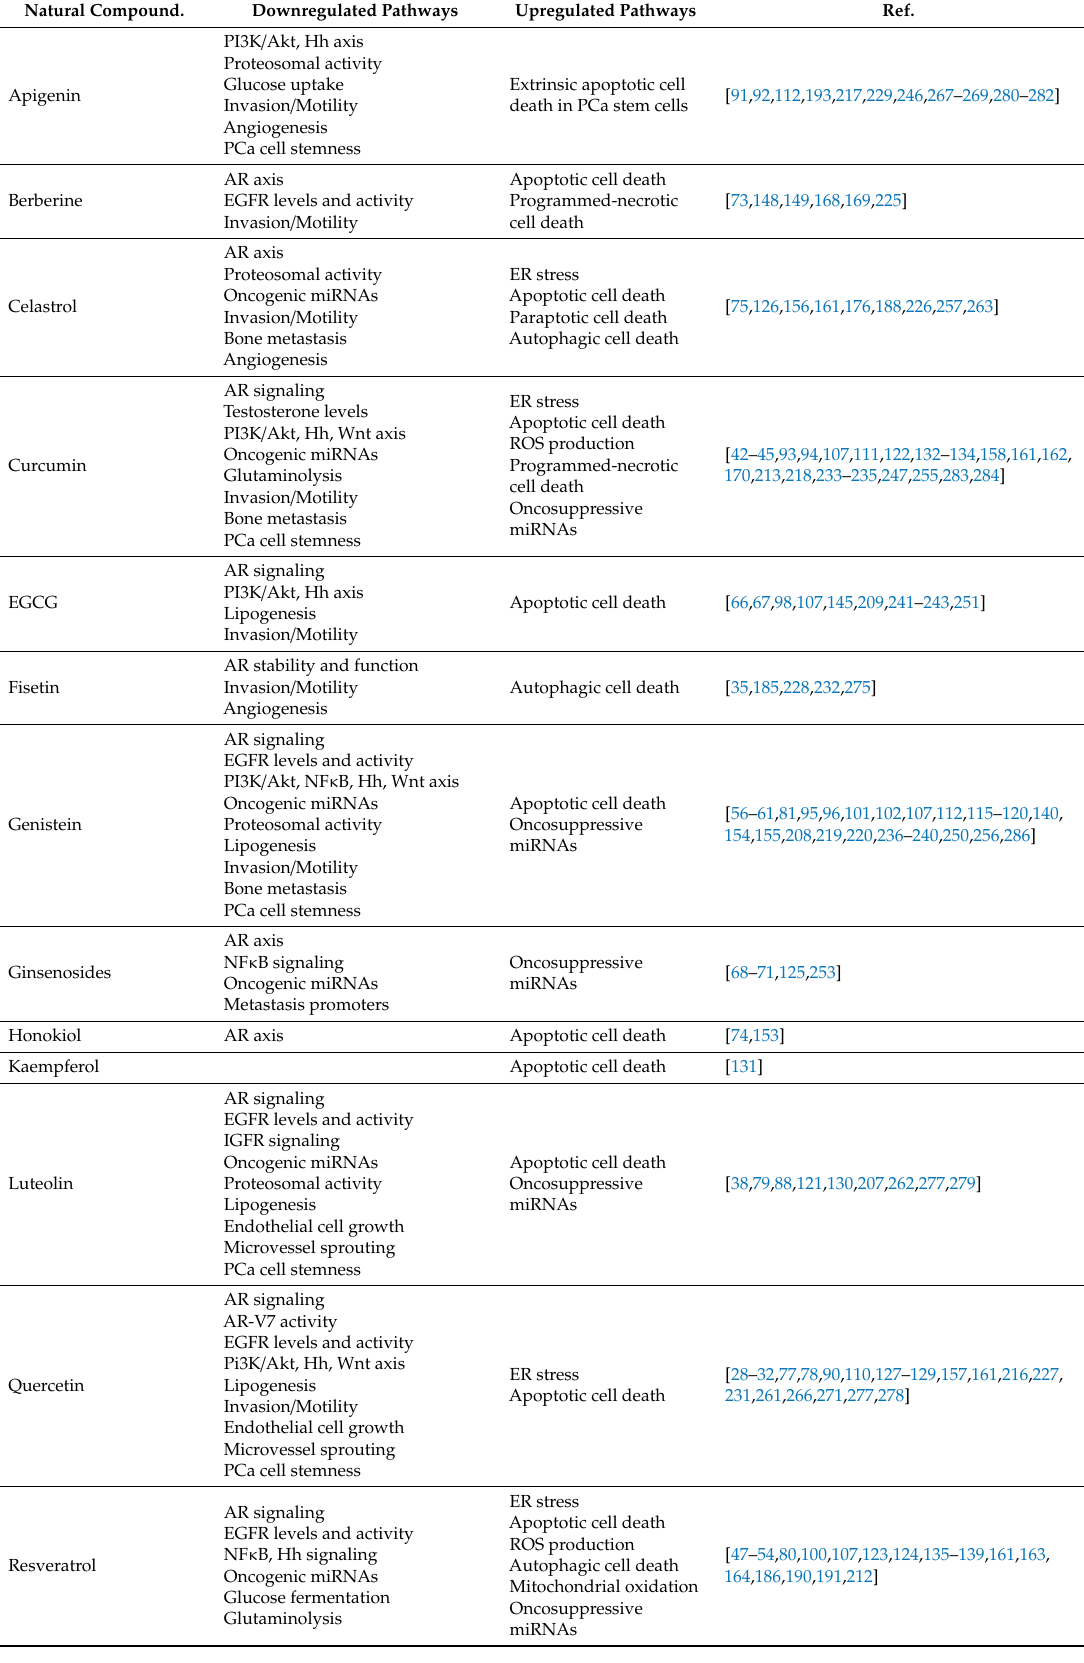
Table 1. Main signaling pathways modulated by phytochemicals in PCa. Natural